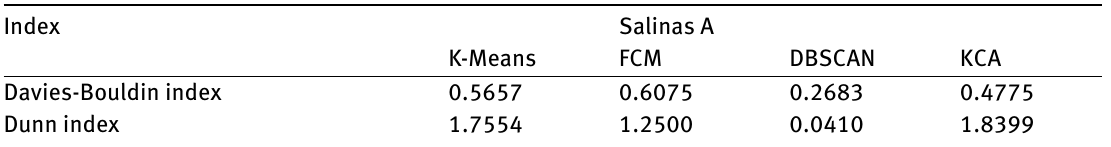
Table 7: Quantitative internal validity evaluation over Salinas A hyper-spectral dataset as obtained by K-means, FCM and KCA algorithms